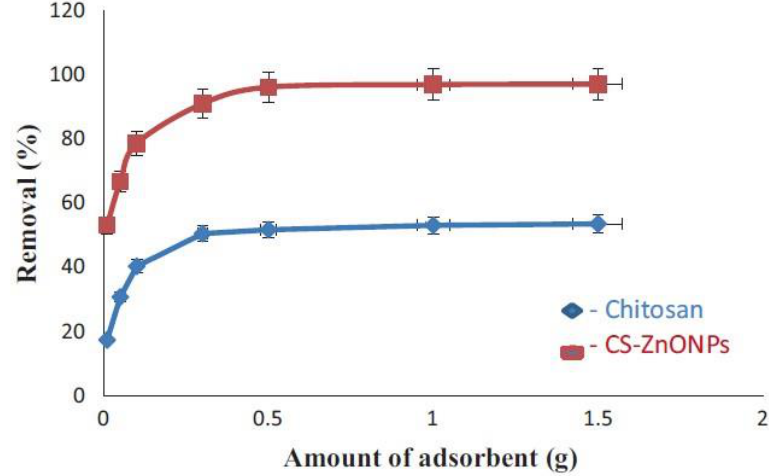
Figure 17. The effect of the amounts of adsorbent on removal percentage of Permethrin pesticide. Reprinted with permission from Ref. [175]. Copyright 2014 Elsevier.